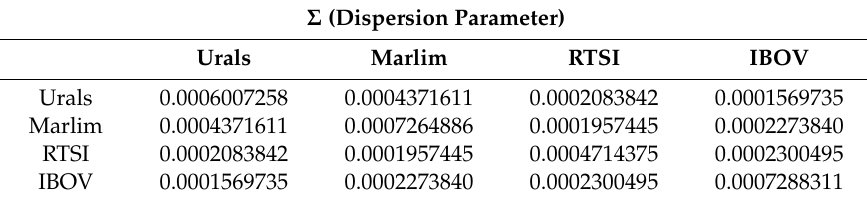
Table A23. MNIG Dispersion parameter Σ for Vector 6: Urals, Marlim, RTSI, IBOV. Σ (Dispersion Parameter)